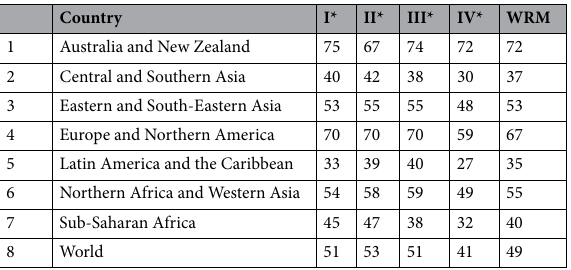
Table 2. Degree of IWRM achievement in the world and main regions (0–100).